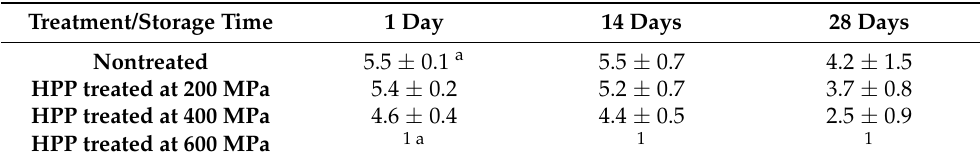
Table 1. Numbers (log 10 cfu/g) of Listeria monocytogenes colonies in inoculated cold-smoked rainbow trout samples at three (1, 14, and 28 days) different storage timepoints. Treatment/Storage Time